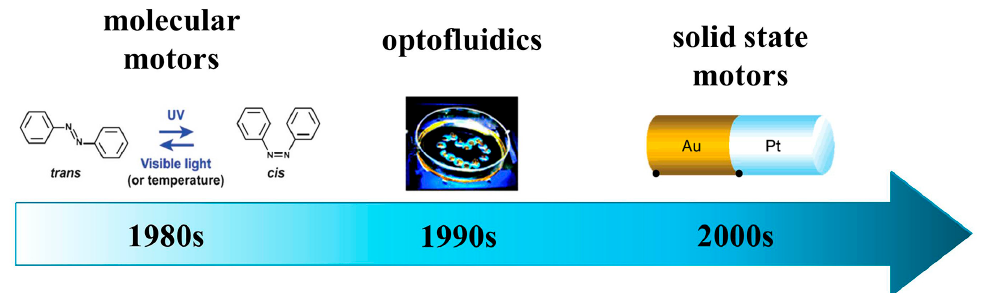
Figure 1. The milestones for the development process of light-powered MNMs: Molecular motors. Reproduced with permission [72]. Copyright 2012, Royal Society of Chemistry. Optofluidics. Reproduced with permission [73]. Copyright 2009, WILEY-VCH. Solid state motors. Reproduced with permission [74]. Copyright 2004, American Chemical Society.